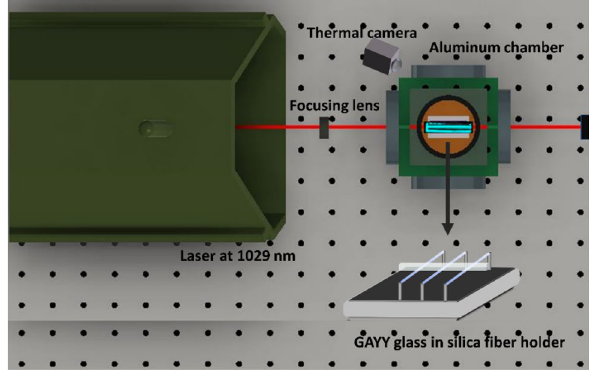
Figure 6. The experimental setup used for temperature measurements in laser cooling experiment. The zoomed-in circle shows GAYY glass placed on the silica optical